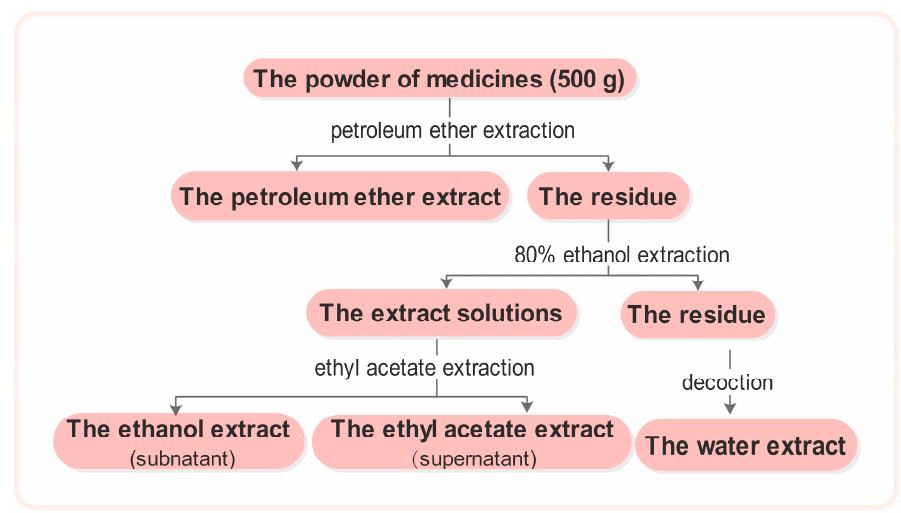
Figure 1. The extract flow chart of the 113 traditional Chinese medicines.